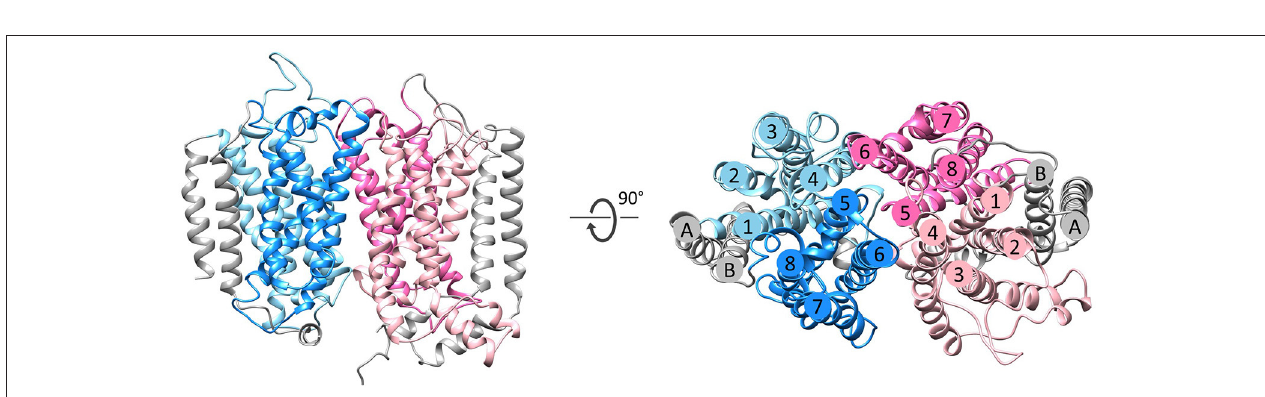
FIGURE 3 | Fold of homologous membrane subunits ActC and ActF. ActC (pink) and ActF (blue) seen from the membrane (left) and from the top (right). The N- and C-terminal helices (TMHs A-B), which form a helix dimer, are colored in gray. The four-helix bundles are shown in light pink/blue (TMHs 1–4) and dark pink/blue (TMHs